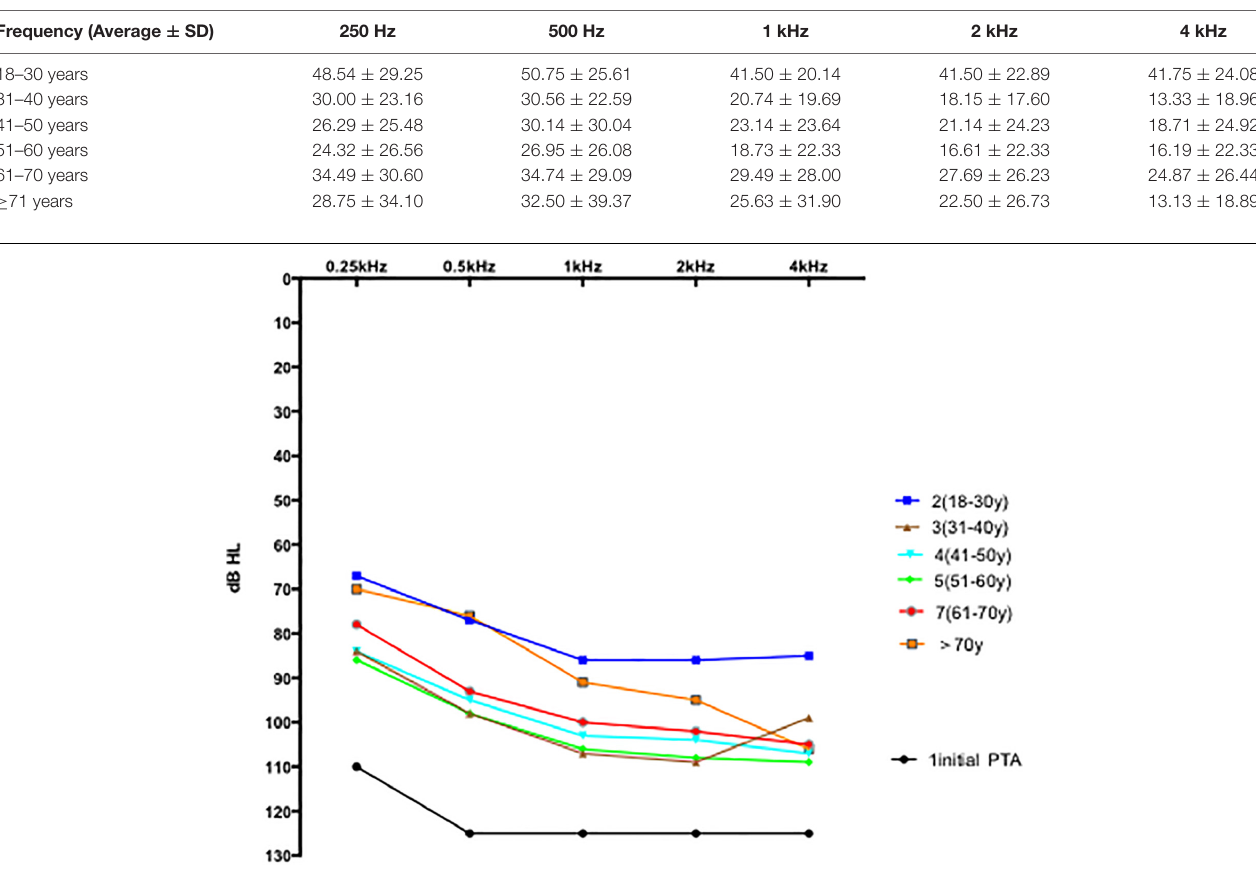
FIGURE 3 | PTA in six groups 1 month